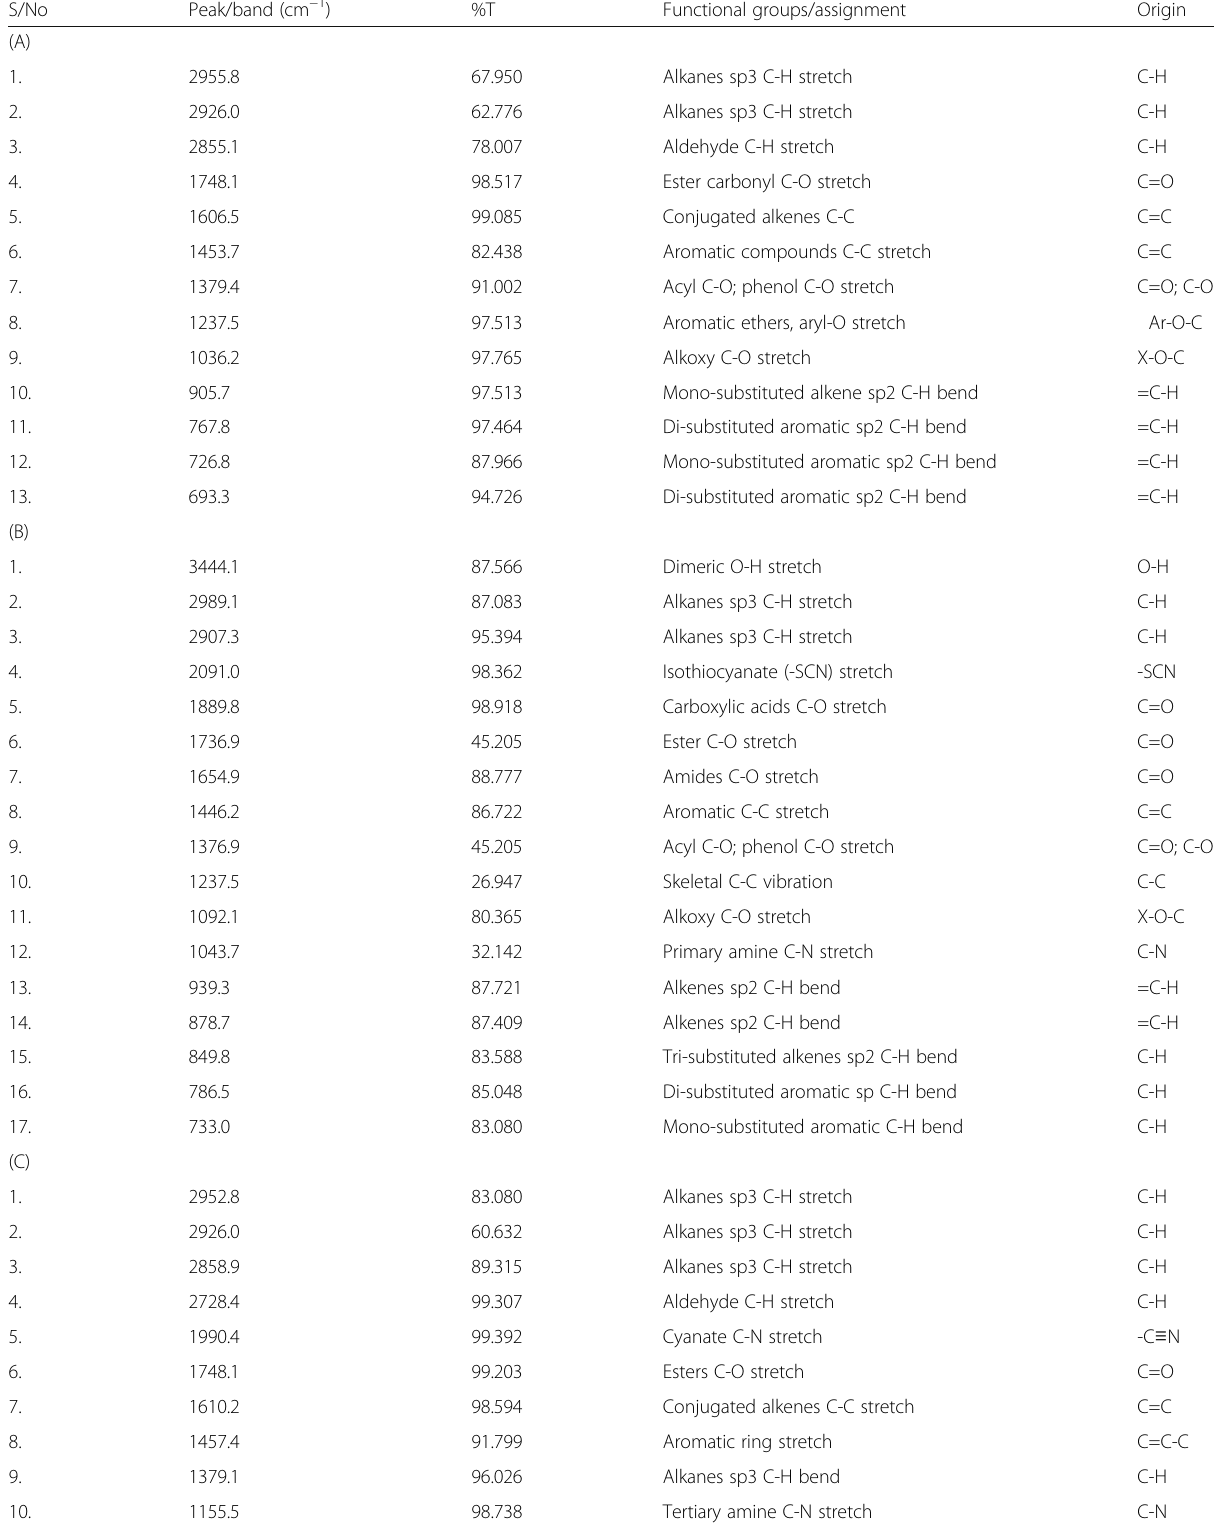
Table 3 FT-IR spectra peak values: (A) petroleum ether extract of A . occidentale , (B) ethylacetate extract of A . occidentale , (C) n